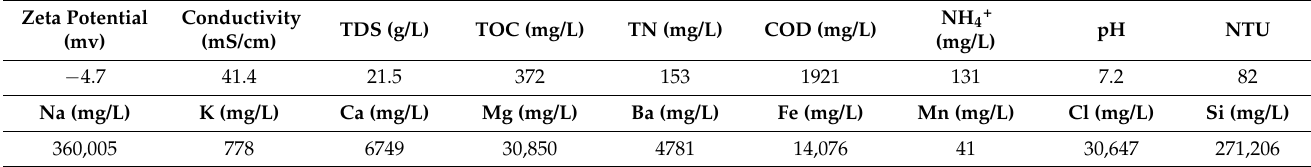
Table 1. Water quality characteristics of shale gas